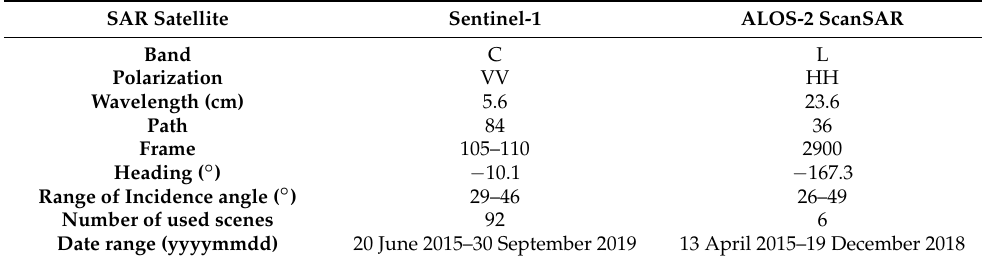
Table 1. Characteristics of the SAR data utilized in the Weihe Basin.